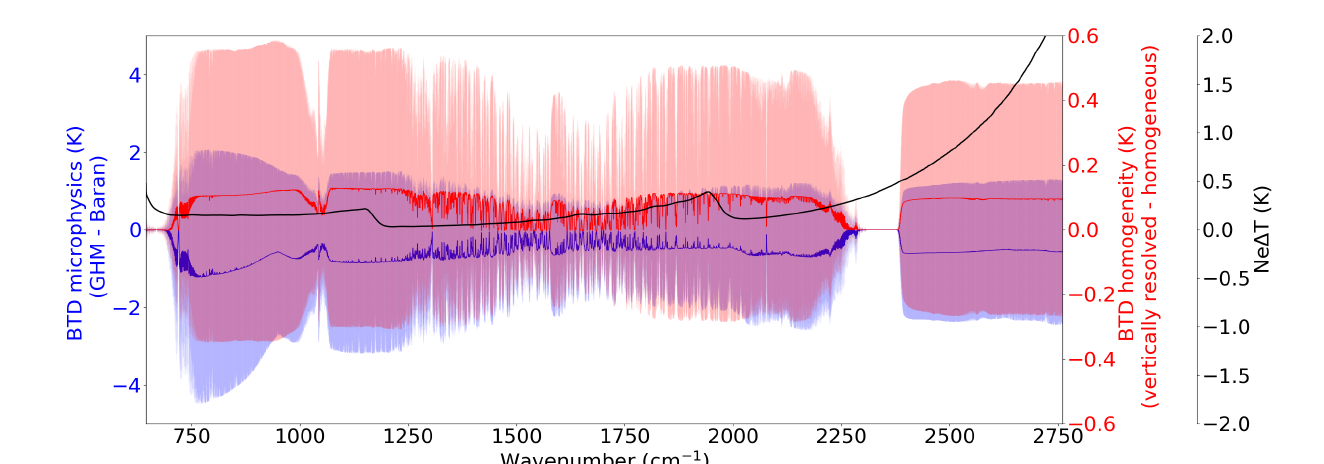
Figure 3. Brightness Temperature Difference (BTD) averaged over the 1424 ice-only cloud profiles (IC) (solid line) and standard deviation (colored area) simulated from different hypothesis in the forward model. The blue curve (left scale) corresponds to the BTD due to the use of different microphysical models, namely the Baran et al. (2014) [50] model and the General Habit Mixture (GHM) model of Baum et al. (2007) [48]. The red curve (right scale) corresponds to the BTD due to the use of the homogeneous profile instead of a vertically resolved ice water content profile. Noise equivalent temperature difference ( Ne ∆ T , black line, right scale) for a reference temperature of 280 K. All are given for the Infrared Atmospheric Sounding Interferometer (IASI)